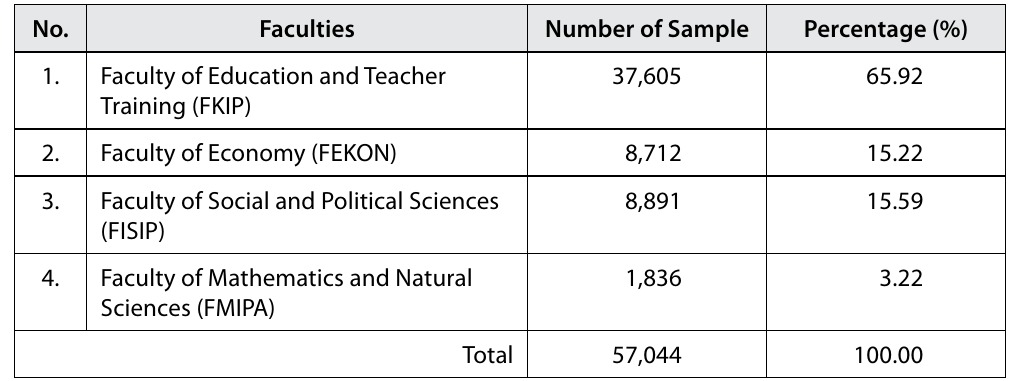
Table 1 Number of samples as percentage of